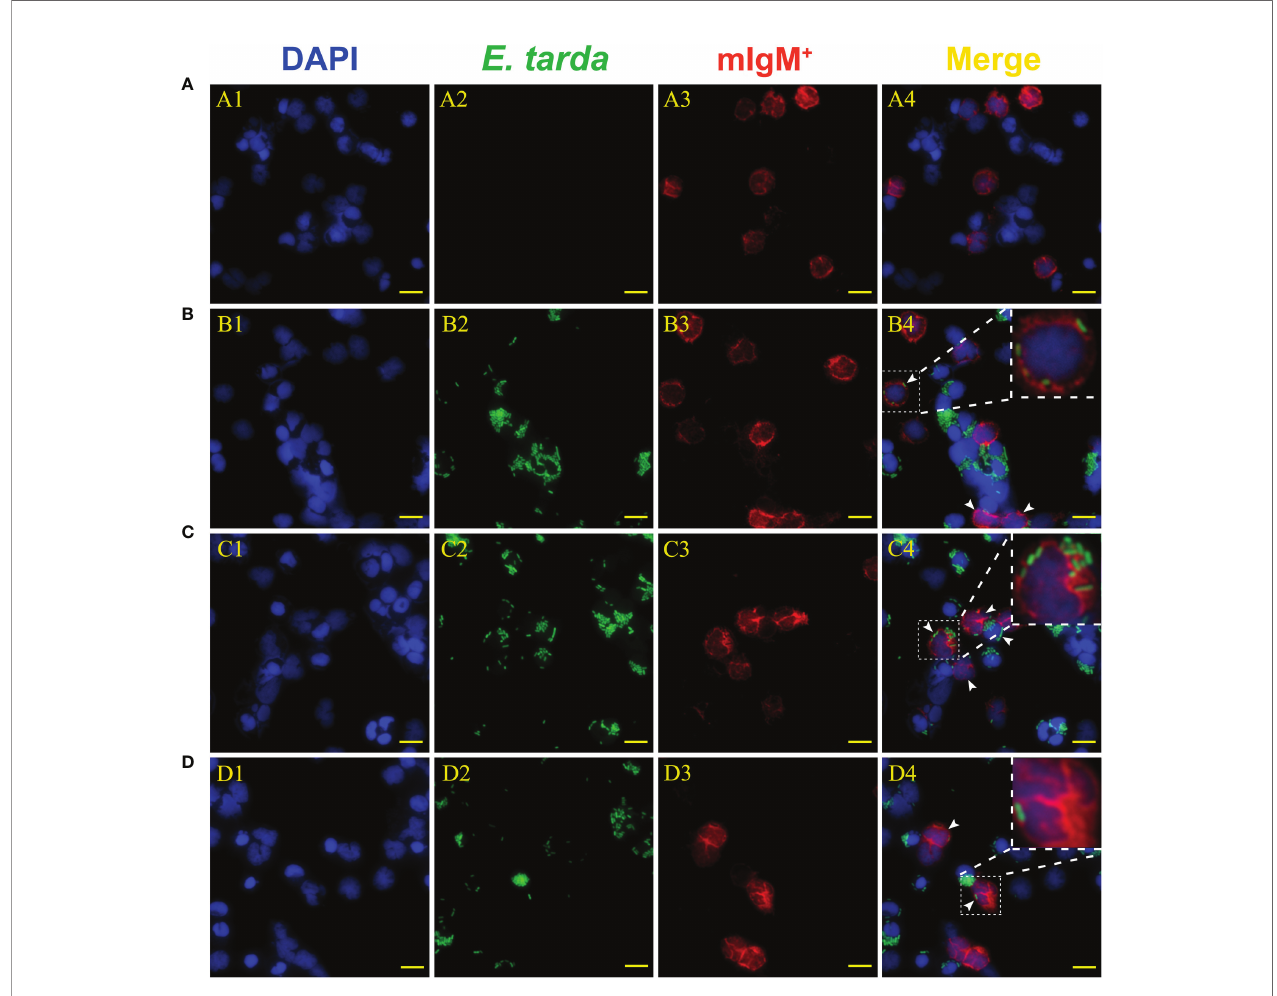
FIGURE 4 | Analysis of phagocytic ability of mIgM + B lymphocytes after incubation with differently treated E . tarda by fl uorescence microscopy. (A) Non-phagocytosed negative control. (B, C) Opsonization of E . tarda using healthy fl ounder sera (B) and antiserum (C) . (D) Fc blocking of the antiserum-opsonized E . tarda . 1: DAPI staining of cell nuclei. 2: FITC-labeled E . tarda . 3: Immuno fl uorescence-stained with anti-IgM mAb and Alexa Fluor ® 649 goat anti-mouse IgG. 4: Merge images of each fl uorescent channel with magni fi ed images of phagocytosed mIgM + B lymphocytes. Arrows indicate the mIgM + B lymphocytes after phagocytosis (Bar = 10 m